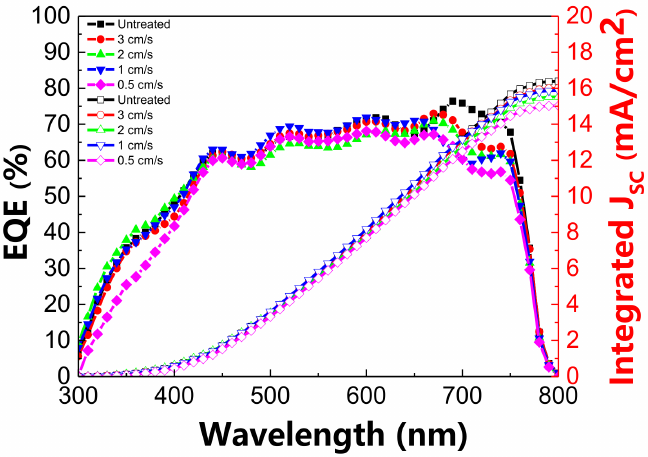
Figure 5. EQE and corresponding integrated photocurrent curves of p-i-n PSCs with He DBDjet treatment on the BCP